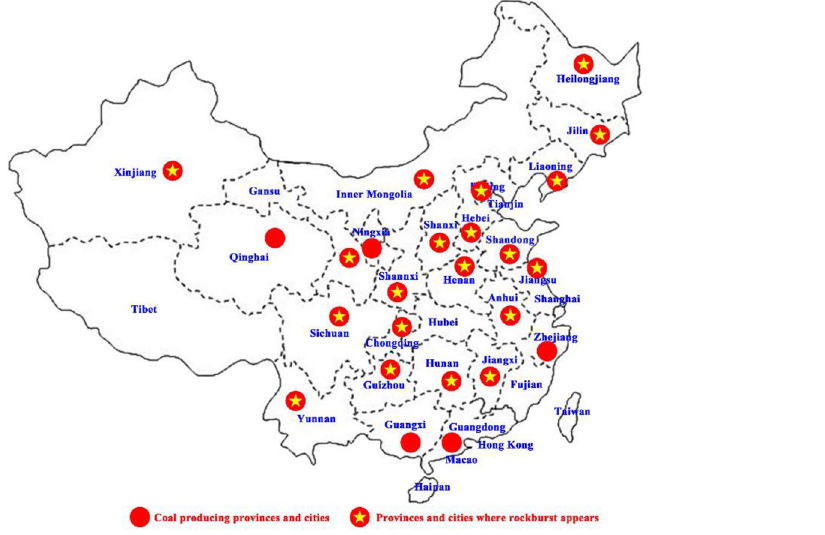
Figure 2. Rockburst coal mine distribution in